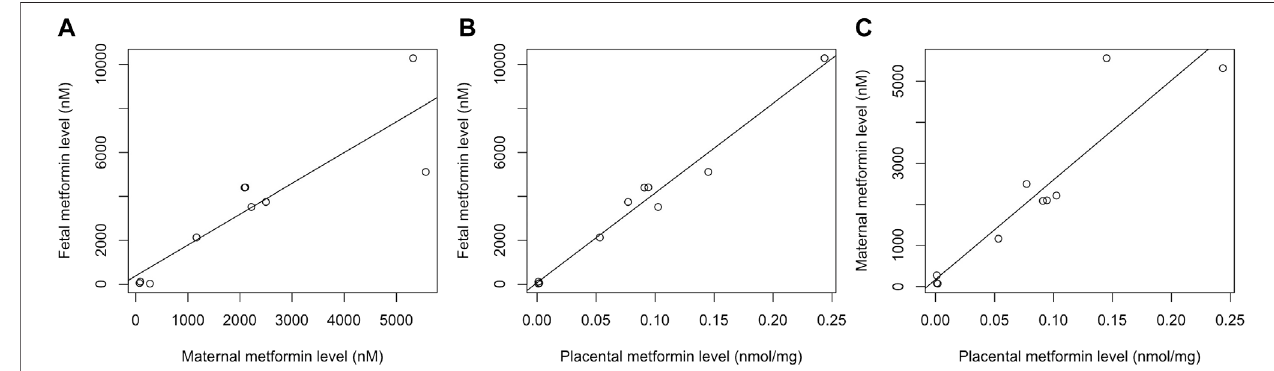
FIGURE 1 | Metformin concentrations following in vivo administration with metformin during pregnancy. N = 10 simultaneously obtained sample trios: maternal plasma, umbilical cord plasma, and placental tissue. (A) Relationship between fetal and maternal plasma metformin concentrations, R 2 = 0.84, p < 0.001; (B) Relationship between fetal plasma and placental metformin concentrations, R 2 = 0.97, p < 0.001; (C) Relationship between maternal plasma and placental metformin concentrations, R 2 = 0.76, p <